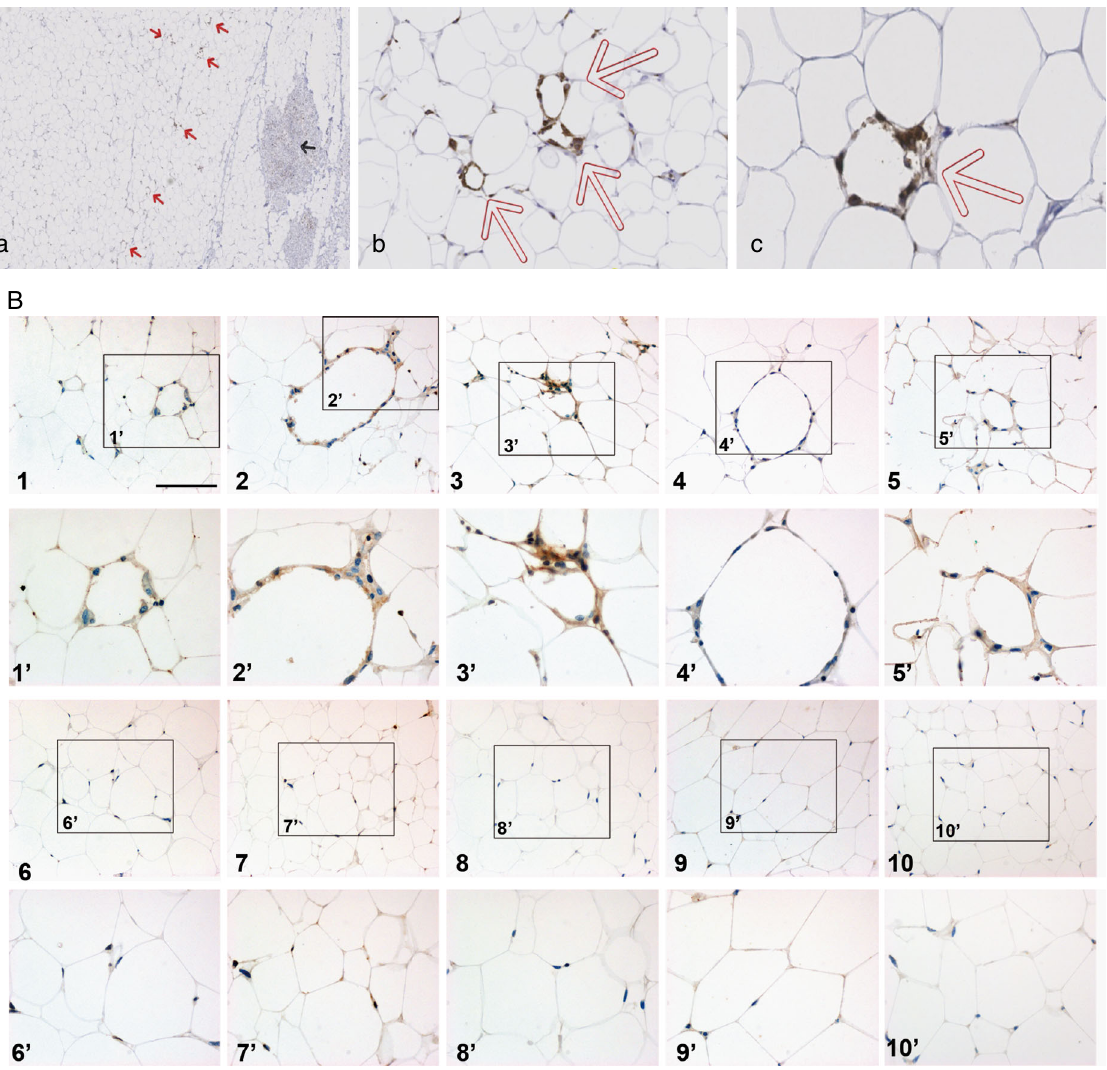
Fig. 1 CLS are found in MAT and macrophages constituting CLS are pro-in fl ammatory. a Photomicrographs of CD68 stained tumor slides showing macrophages in isolated ring-like formations surrounding dying or dead adipocytes (indicated by red arrows ). Density of CLS in breast fat tissue away from tumor border was scored as number of CLS divided by area of fat tissue. a ×25 magni fi cation, red arrow : CLS, black arrow : tumor; b ×150 magni fi cation; c ×300 magni fi cation of CLS detected in the MAT of an obese patient (BMI = 30 kg/m 2 ) exhibiting hypertrophied adipocyte (mean adipocyte diameter 82.09 µm). b IL6 expression was evaluated in 5 samples exhibiting CLS obtained from overweight patients (BMI from 26.4 to 29.5 kg/m 2 ) (Samples 1 to 5) (×200 magni fi cation). The fi gures below (numbered 1 ’ to 5 ’ ) show two-fold- magni fi ed views of selected areas indicated by insets. Similar experiments were performed in samples without CLS obtained from normal weight patients (BMI from 17.9 to 24.8 kg/m 2 ) numbered (6 to 10), with two fold-magni fi ed views of selected areas (6 ’ to 10 ’